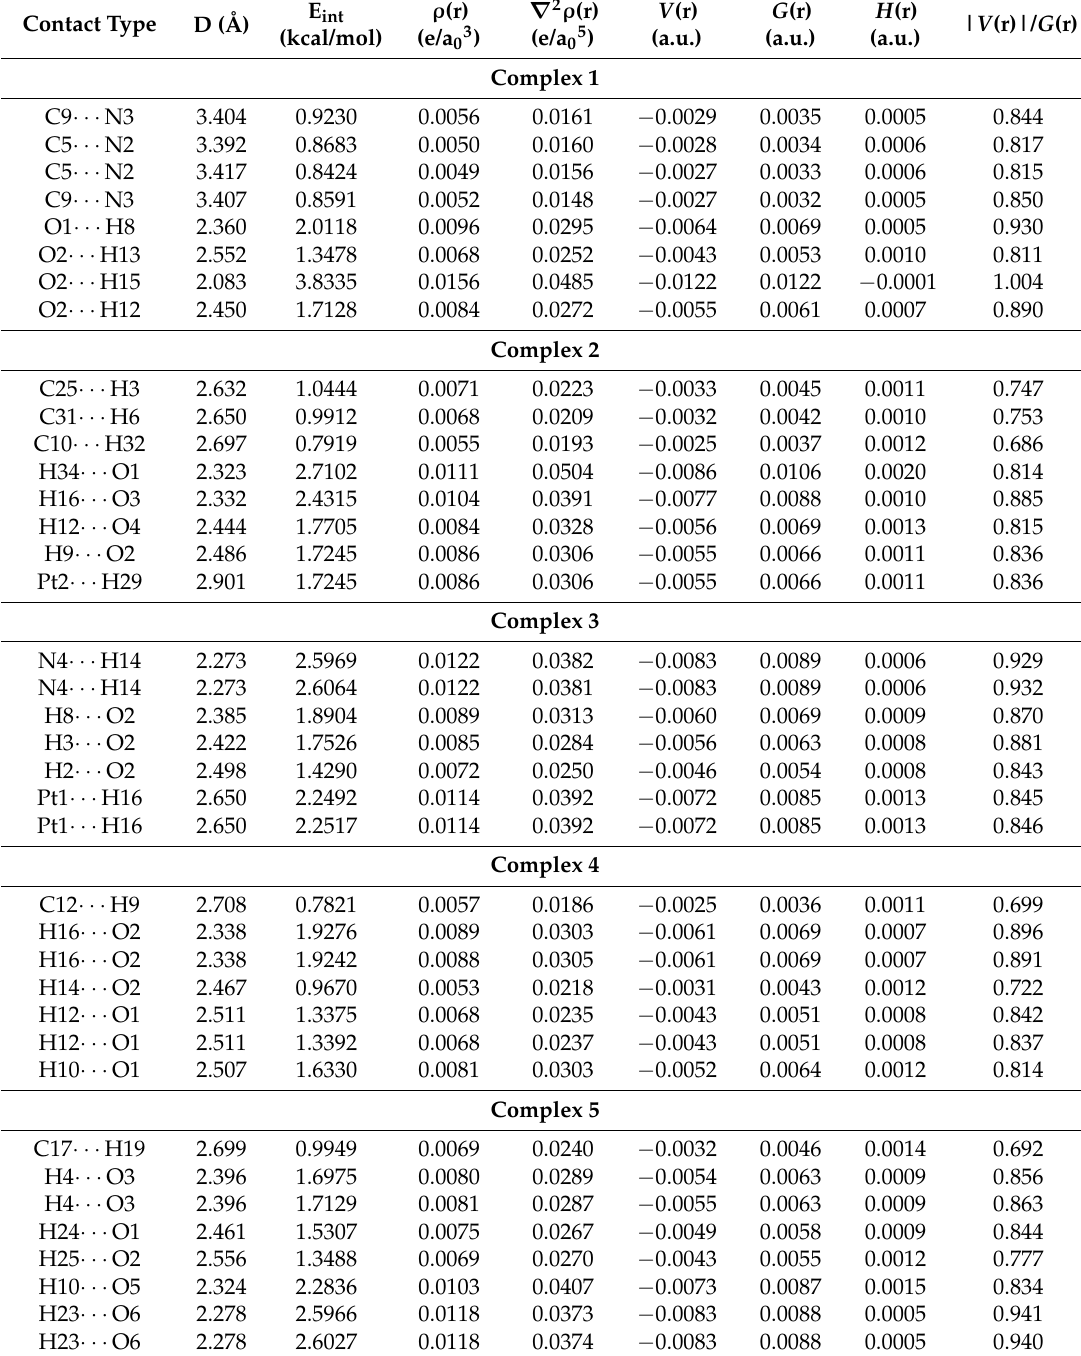
Table 2. Topological parameters obtained from the atom in molecules (AIM) analyses of the most important contacts observed from the Hirshfeld analyses of the Pt